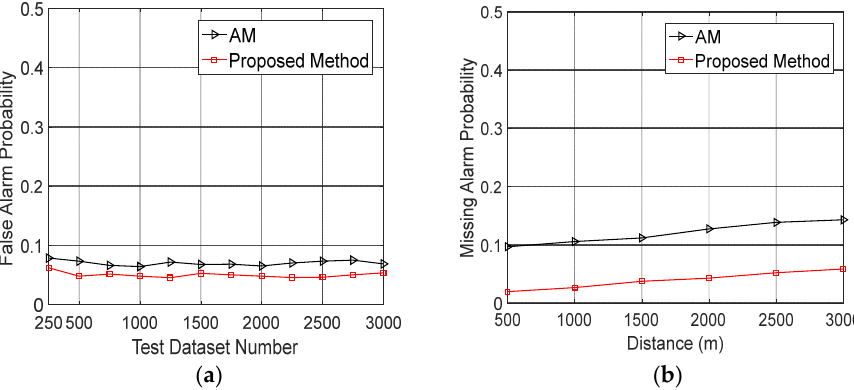
Figure 7. ( a ) The false alarm probability for different numbers of outdoor datasets, and ( b ) the missing alarm probability for different outdoor distances. AM: advanced method.